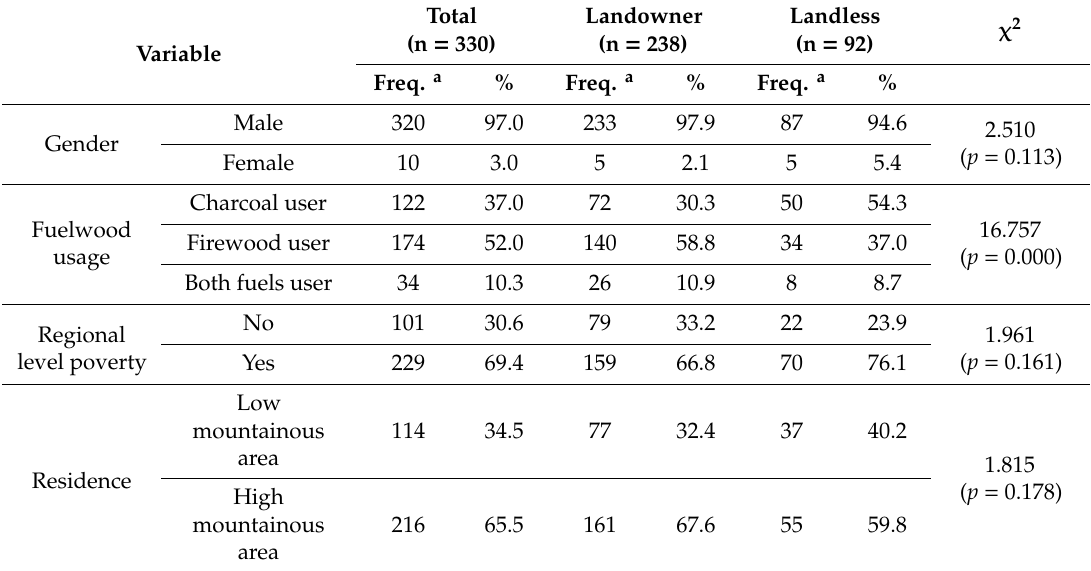
Table 2. Descriptive statistics for the categorical socio-economic characteristics of sampled